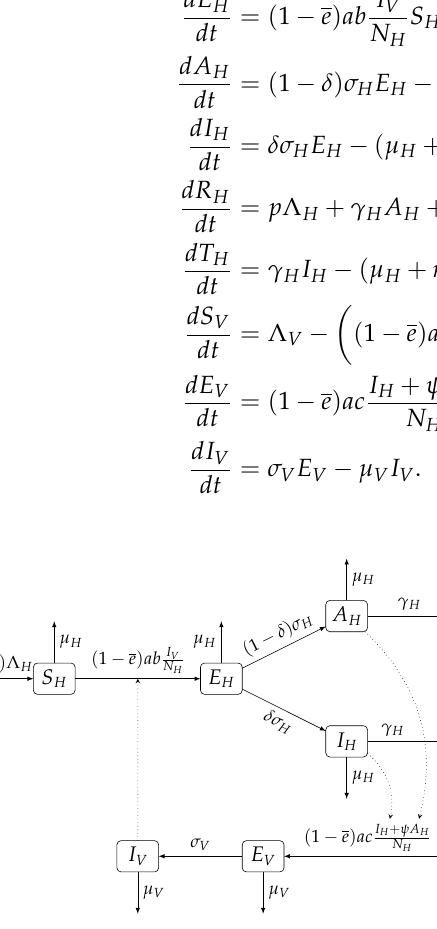
Figure 1. Scheme of the compartmental ODE model for yellow fever transmission. Dotted lines represent the influence of a compartment over the transmission